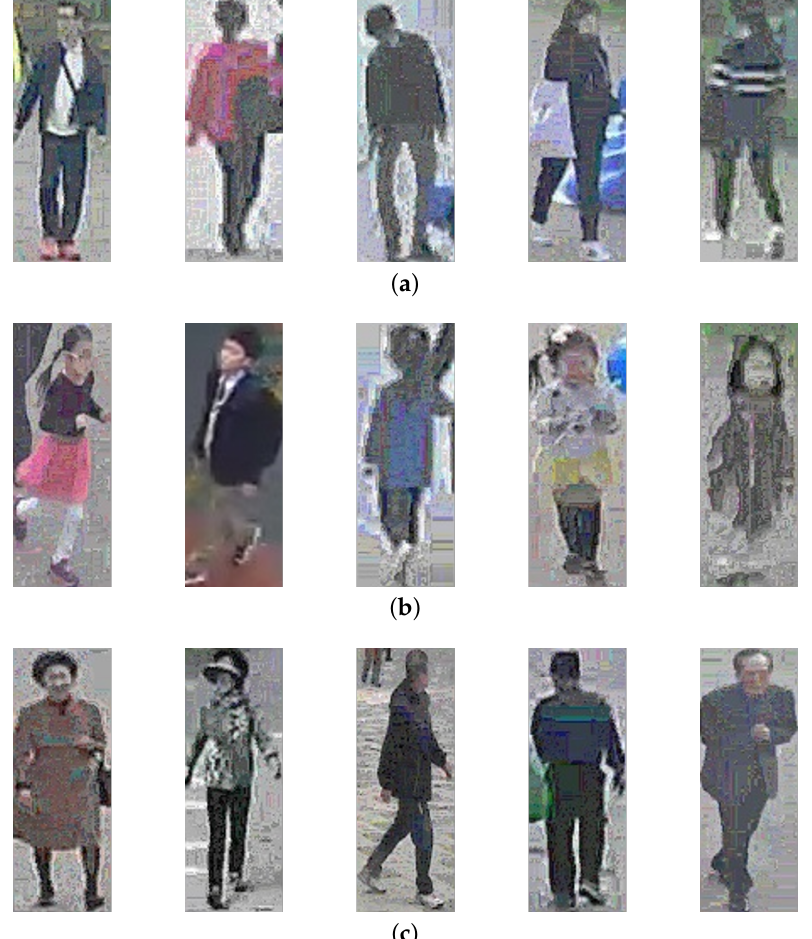
Figure 3. Example images from each class in the dataset: ( a ) Adult class, ( b ) Child class, and ( c ) Elderly class. It should be noted that in each class, there are also images of pedestrians moving in different directions (front-facing, back-facing, side-facing) and with different lighting conditions. Variation in the distance of pedestrians against the camera causes many images to have less-than-ideal quality, which should be taken into consideration in real-life